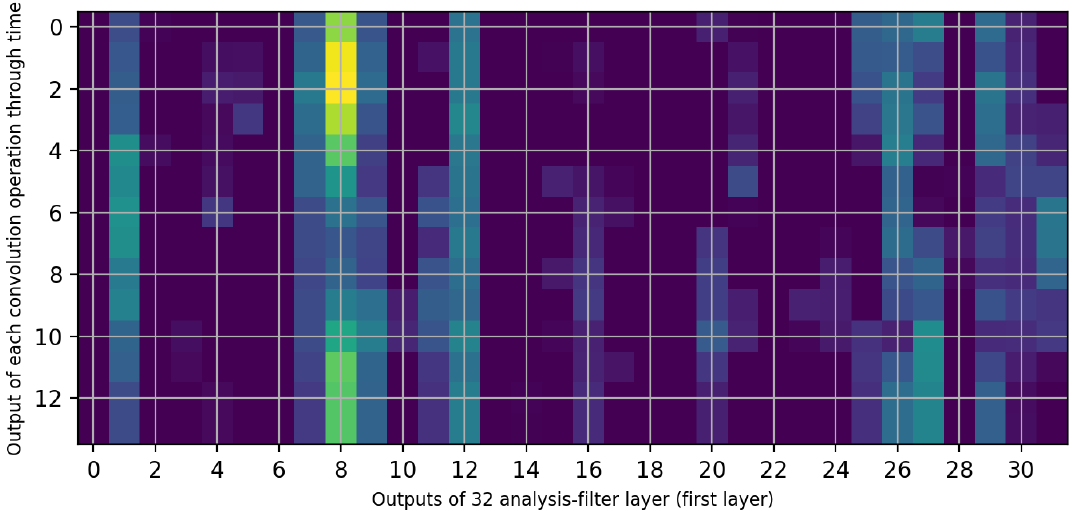
Figure A2. Outputs of analysis-filters for an input number of 240).